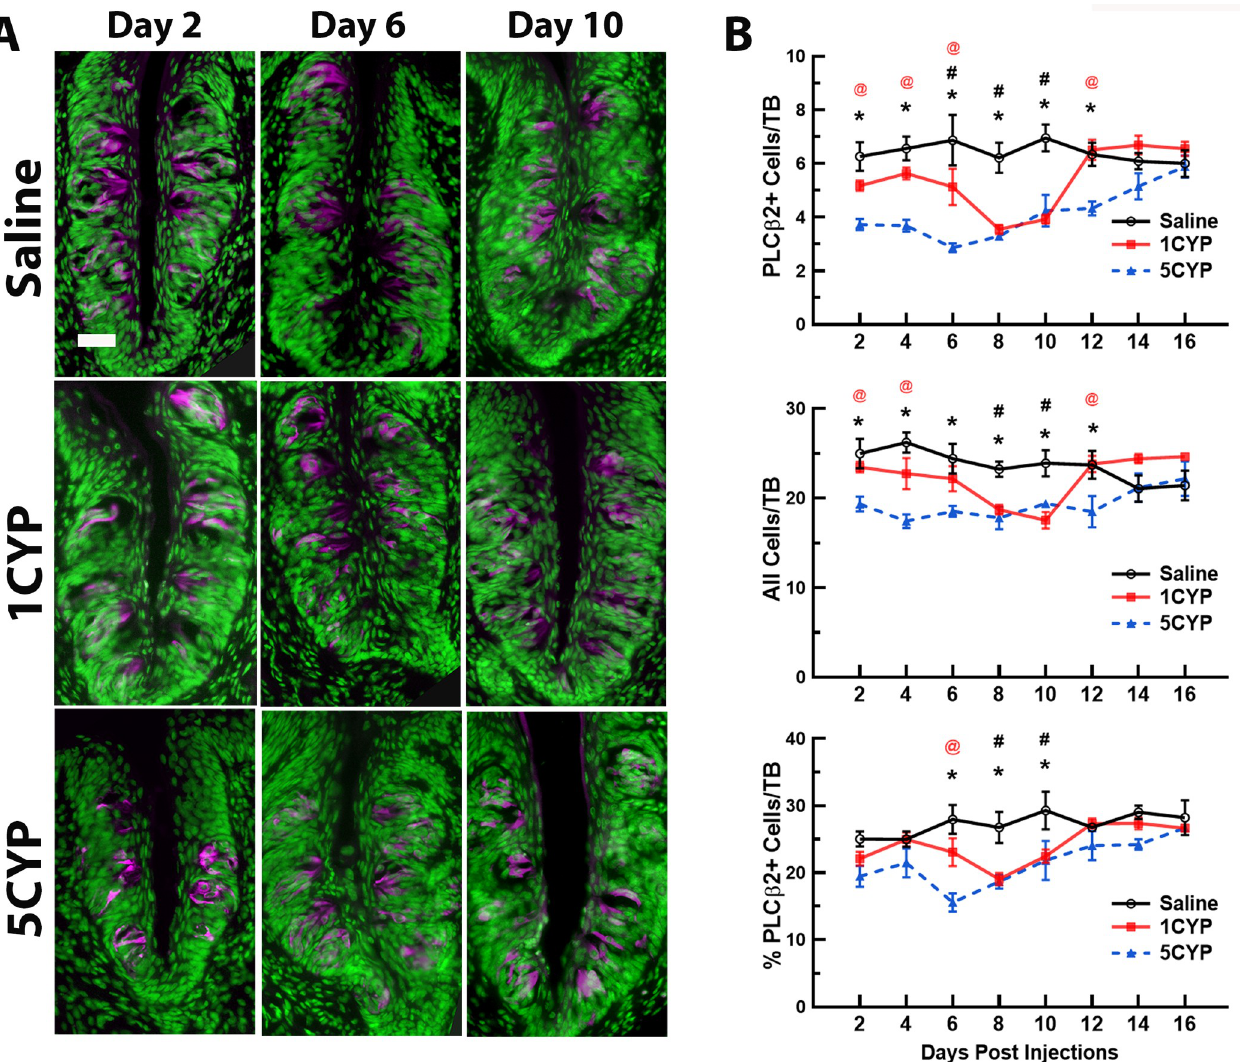
Fig 2. CYP dosing conditions differentially altered PLC β 2 expression in circumvallate taste buds. (A). PLC β 2+ cells (magenta) in taste buds after saline injections (Saline, top row), a single injection of 75 mg/kg CYP (1CYP, middle row), or five injections of 15 mg/kg CYP (5CYP, bottom row) at 2 days (left column), 6 days (middle column), and 10 days (right column) post injection. Tissues were counter-reacted with Sytox green, a nuclear marker. For the 1CYP mice, PLC β 2+ cells were much reduced 8–10 days after injection. For the 5CYP mice, there were fewer PLC β 2+ cells at 6–10 days post injection. Scale bar = 20 μ m. (B) Means ± SEM of PLC β 2+ cells (top graph), total cells (middle graph), and percent of PLC β 2+ cells per taste bud (bottom graph) are plotted over days post injection. For 1CYP mice, PLC β 2+ signal began to decrease at 6 days and was significantly lower than controls at 8 and 10 days after CYP injection. For 5CYP mice, PLC β 2+ and total number of cells per taste bud were significantly lower than saline controls 2–12 days post injection and significantly less than 1CYP mice at 2–6 and 12 days post injection. The percent of PLC β 2-labeled cells in 5CYP mice were lower than 1CYP mice at 6 days and lower than controls days 6–10. All Ps < .05 or less: (1) � 5CYP < Saline, (2) # 1CYP < Saline, and (3) @ 5CYP <